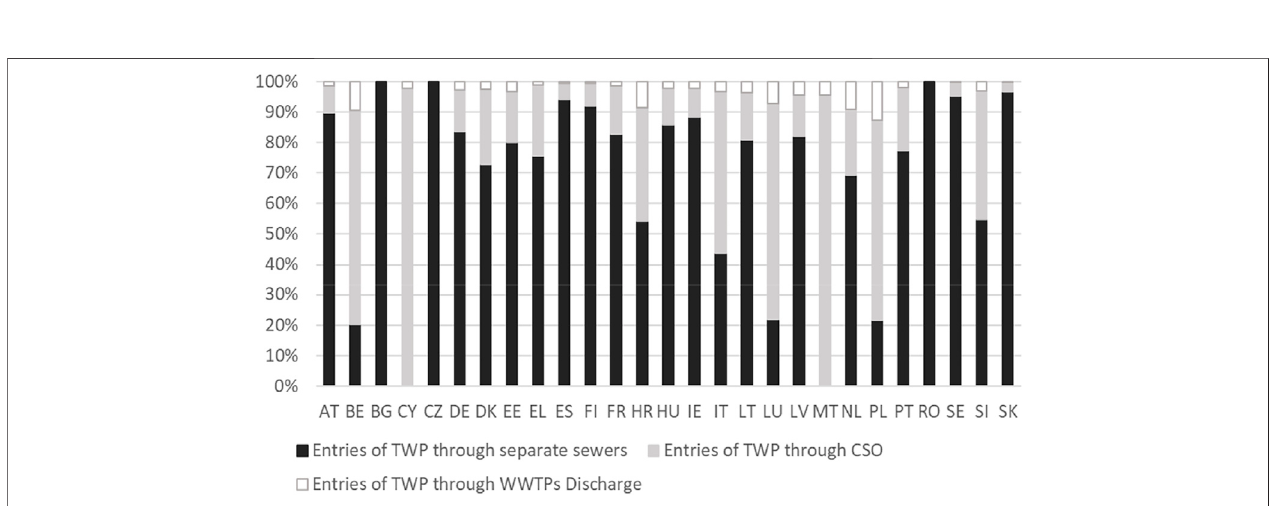
FIGURE 4 | Share of separate sewers, CSO, and WWTPs discharge regarding the environmental input of TWP (some MS do not report plausible CSO data/CS ratio data). Labels on the x -axis refer to country codes ( Table 2 ).